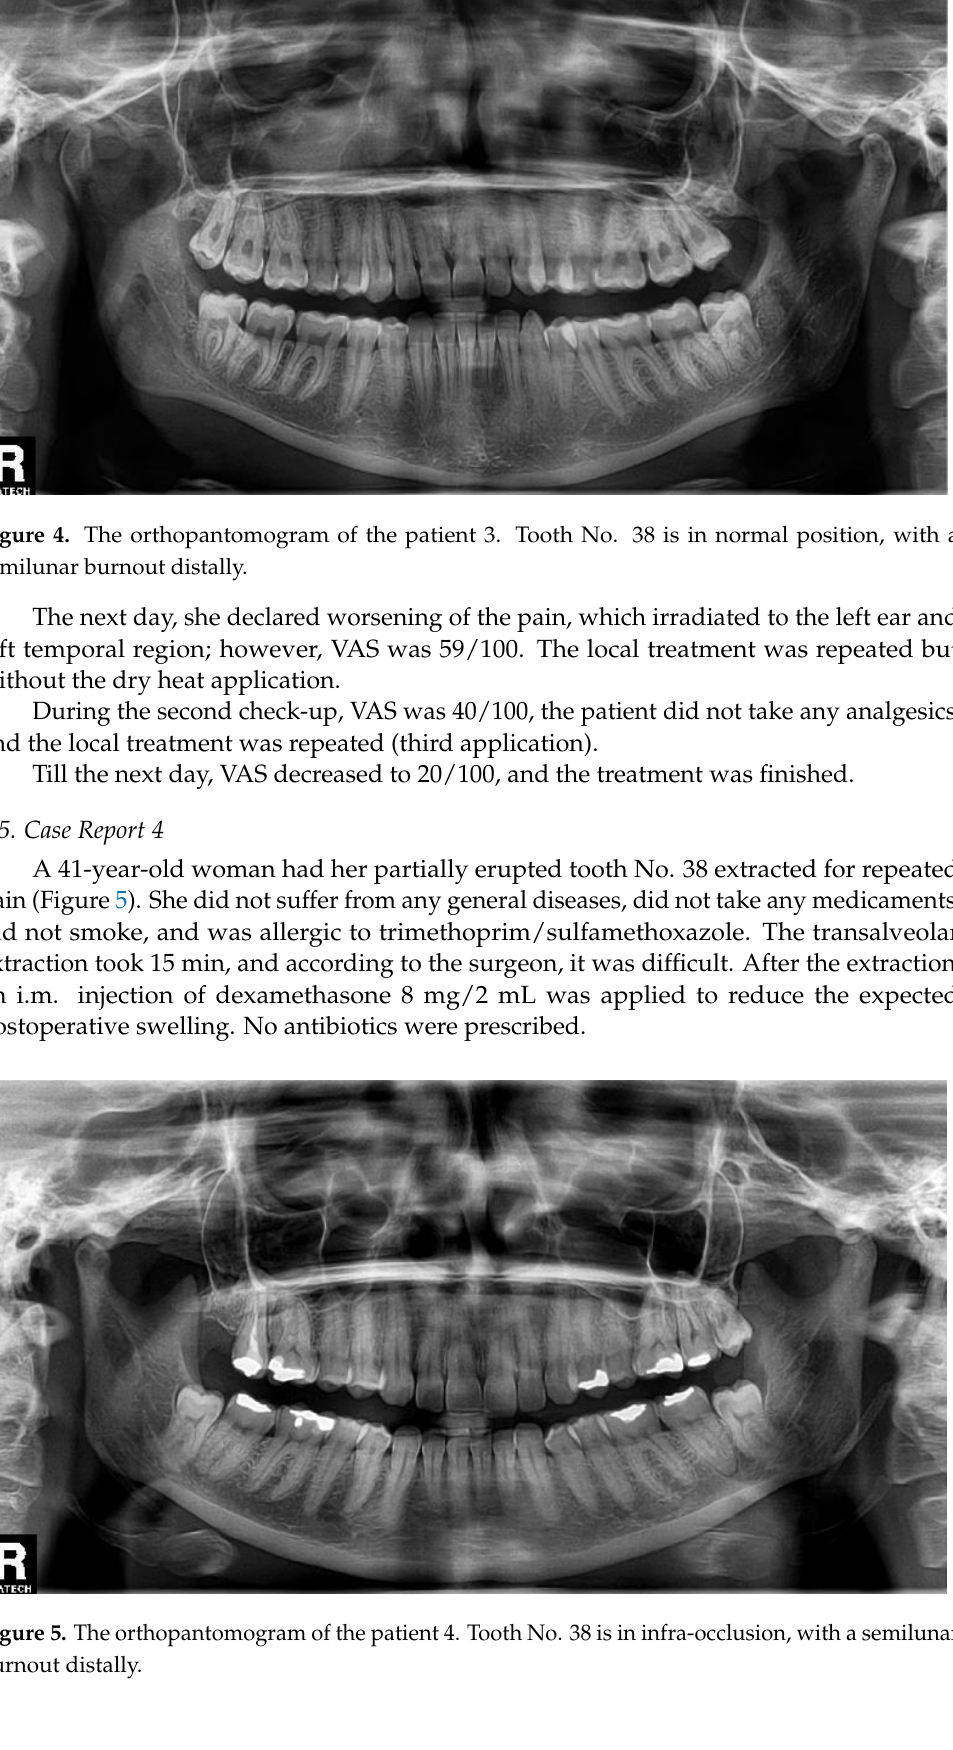
5 of 10 Figure 3. The orthopantomogram of the patient 2. Tooth No. 38 is in normal position, slightly dis- tally inclined, with a semilunar burnout distally. The OPG was not taken at our department. Two days after the extraction, she started to feel pain in the extraction wound. Three days later (five days after the extraction), she sought aid at our department. She declared a cruel pain in the wound irradiating to the left ear and left temporal region. The patient took 1 tablet of ibuprofen 400 mg, and the entry VAS was 94/100. There was no extraoral swelling, the wound was empty with exposed bone walls, but the surrounding mucosa was not painful. Without local anesthesia, the wound was rinsed with 3% hydrogen per- oxide, water for injection, and the HA + OCT device was inserted. During the first check-up on the following day, she declared pain irradiating to the left ear, but she did not use any painkillers; VAS was 63/100. The local treatment was repeated. In the second check-up the next day, she complained of pain during the night with VAS 32/100. The local treatment was repeated (third application of the HA + OCT device). Until the third check-up, VAS decreased to 8/100, and the treatment was finished. 3.4. Case Report 3